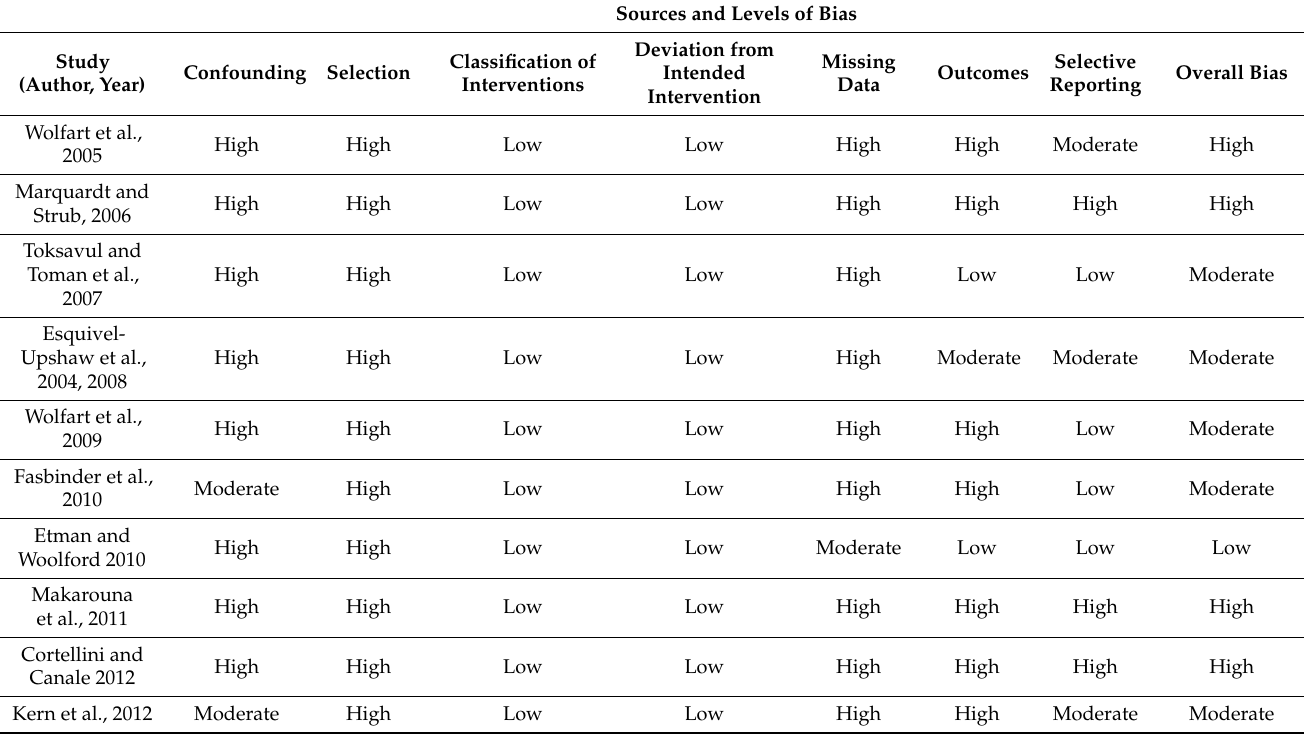
Table 3. Quality assessment results of the included studies (Scale: